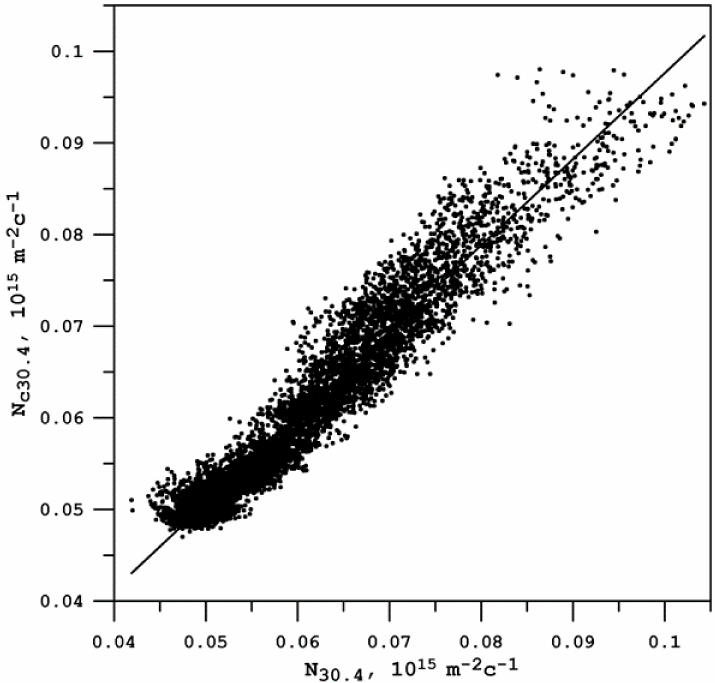
Figure 3. Comparison of the calculated values of the radiation intensity in the 30.4 nm line with the observed